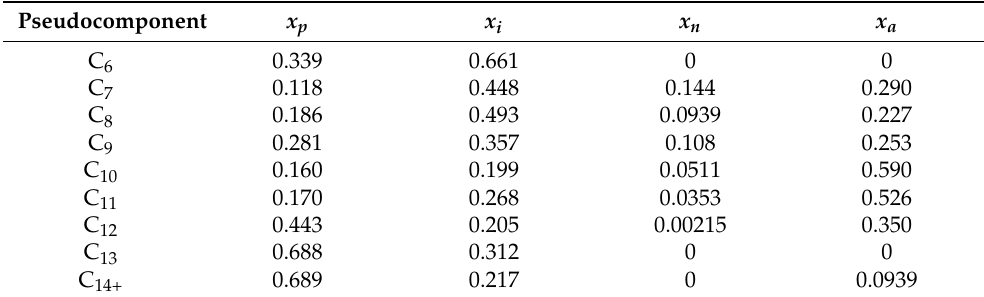
Table 12. Average PINA distribution for each SCN for the rich gas type. The mole fractions of paraffins, isoparaffins, naphthenics and aromatics are denoted x p , x i , x n and x a , respectively.